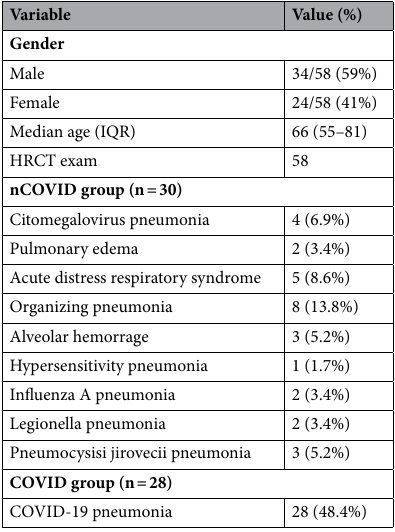
Table 1. Descriptive baseline characteristics of our study population (n = 58). IQR Inter-Quartile Range, HRCT High-Resolution